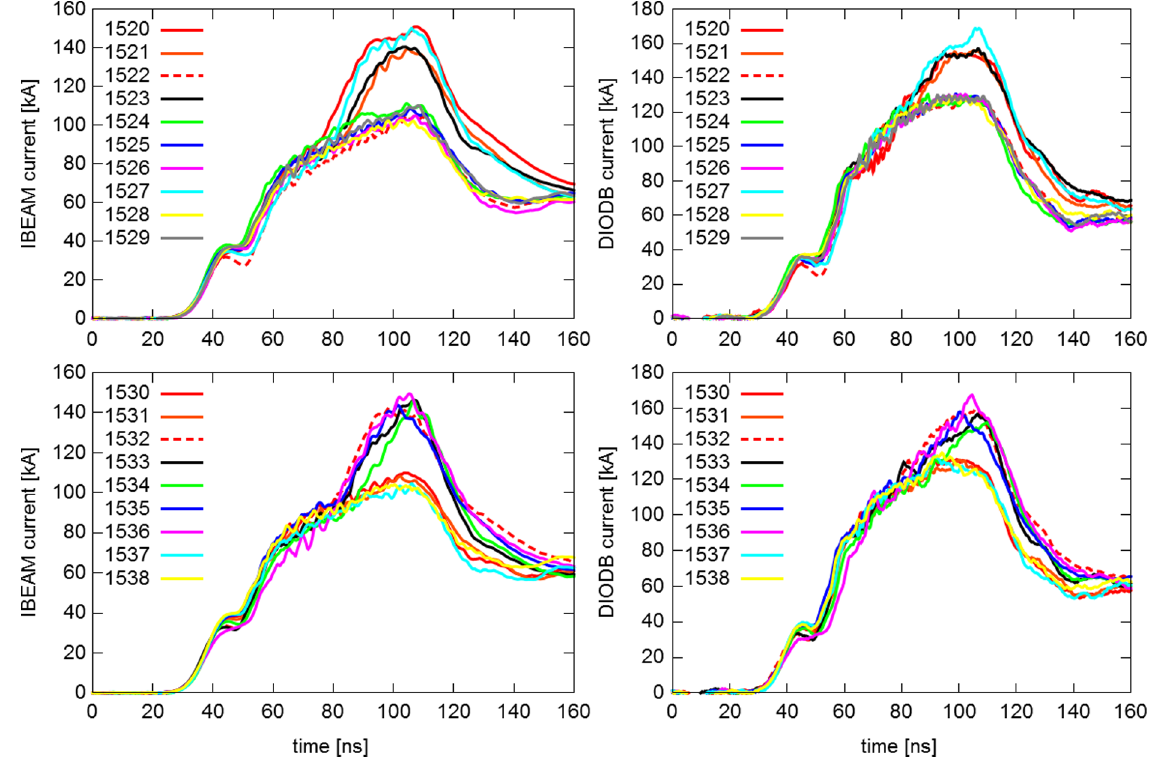
FIG. 14. The IBEAM and DIODB currents from shots 1520 through 1539. All shots are 7-7